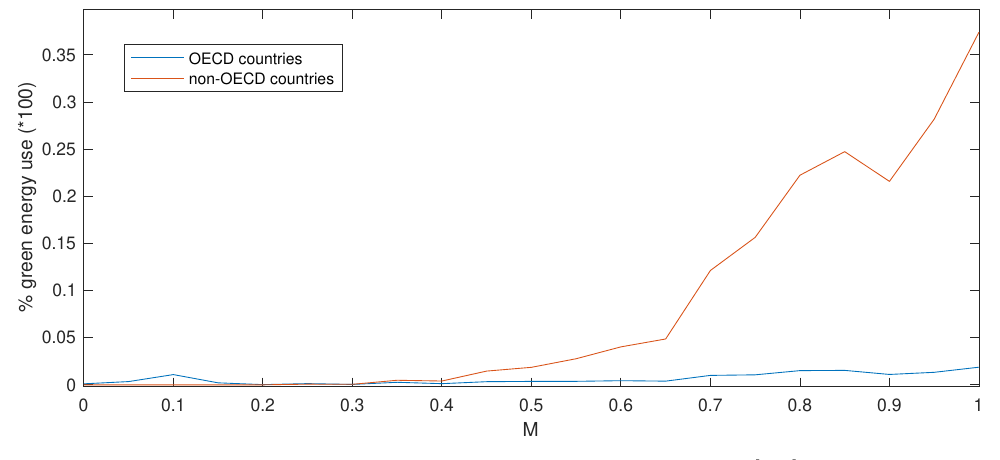
Figure 3. Percentage green energy with e i + Me j with M ∈ [ 0,1 ] . Table 5. Parameter calibration for non-spillover parameters, linearized model.